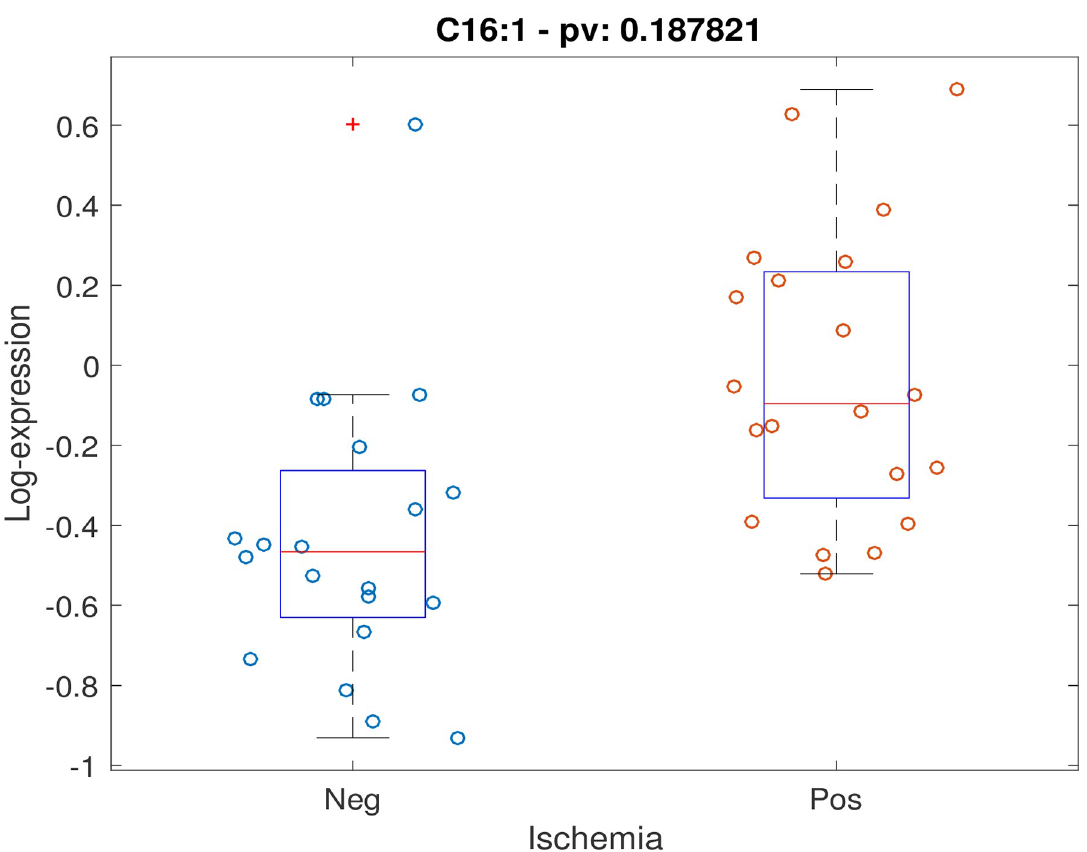
Fig 5. Scatter plot of stress-delta in C16:1 for patients who were positive versus negative for ischemia. When assessing changes in metabolite levels across timepoints while controlling for age, gender and BMI, 5 metabolites had FDR < 0.2: alanine, C14:1-OH, C16:1, C18:2,